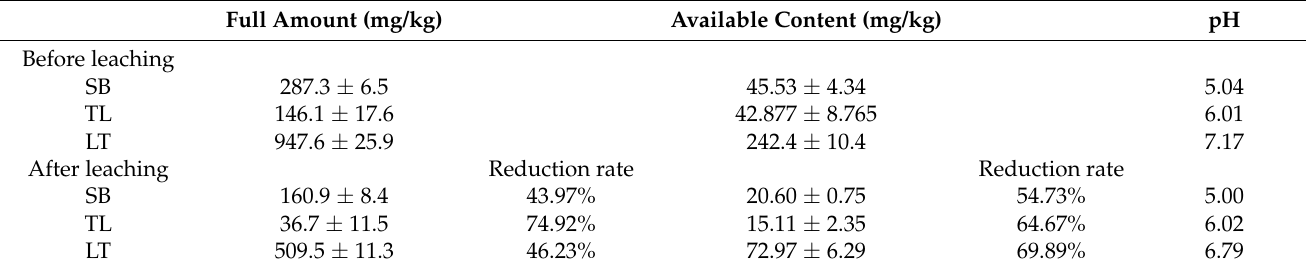
Table 5. The heavy metal Pb content and pH of soil before and after